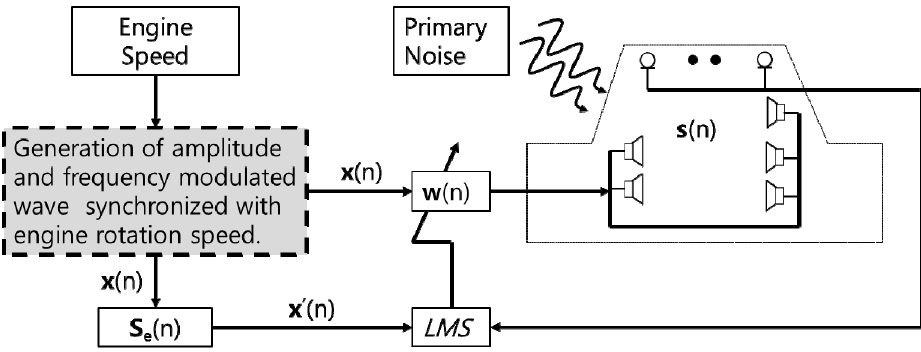
Figure 10. Block diagram of active control of interior noise in a test vehicle based on the OW-FxLMS algorithm.